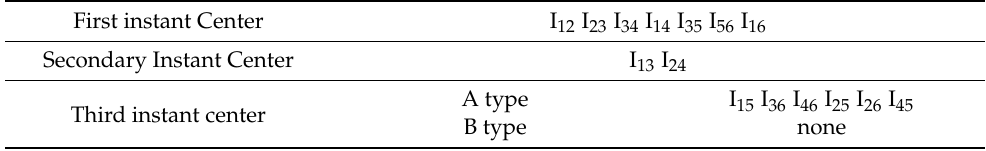
Figure 3. Instant centers of the Stephenson linkage.